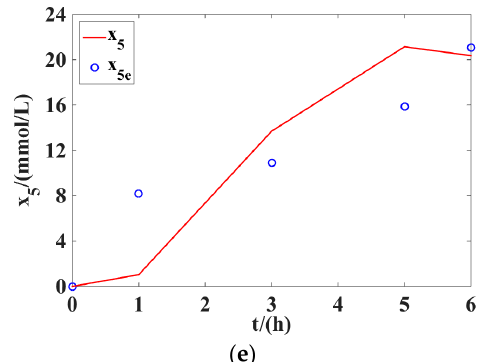
Figure 3. Comparison between the computed values and the experimental data in the single-stage method: ( a ) biomass; ( b ) substrate glycerol; ( c ) 1,3-PD; ( d ) acetic acid; ( e ) ethanol.